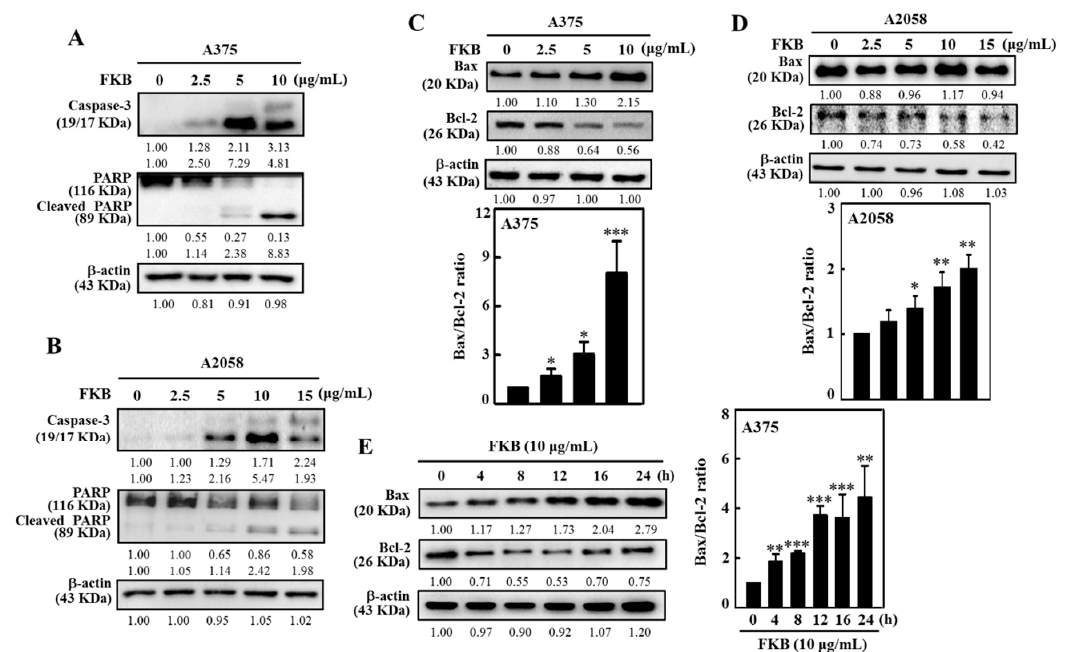
Figure 2. FKB induced apoptosis in human melanoma cells. Di ff erent concentrations of FKB were treated to A375 (0–10 µ g / mL) and A2058 (0–15 µ g / mL) cells for 24 h. ( A , B) The expression levels of FKB-induced activation of caspase-3 and PARP cleavage were measured by Western blot in both A375 and A2058 cells. ( C , D ) The expression levels of apoptosis activator; Bax and inhibitor proteins; Bcl-2 were measured by Western blot in both A375 and A2058 cells. Data were expressed as fold-over control of the Bax / Bcl-2 ratio. (E) 10 µ g / mL of FKB was treated to A375 for 0–24 h. The e ff ect of time on the expressions of Bax and Bcl-2 proteins was measured by Western blot. β -actin was used as an internal control. The Bax / Bcl-2 ratio was represented as fold-over control whose value was arbitrarily assigned as one. Each value was expressed as mean ± standard deviation (SD) of three experiments and the statistical significance was assigned as * p < 0.05, ** p < 0.01, and *** p < 0.001 as compared to the untreated control